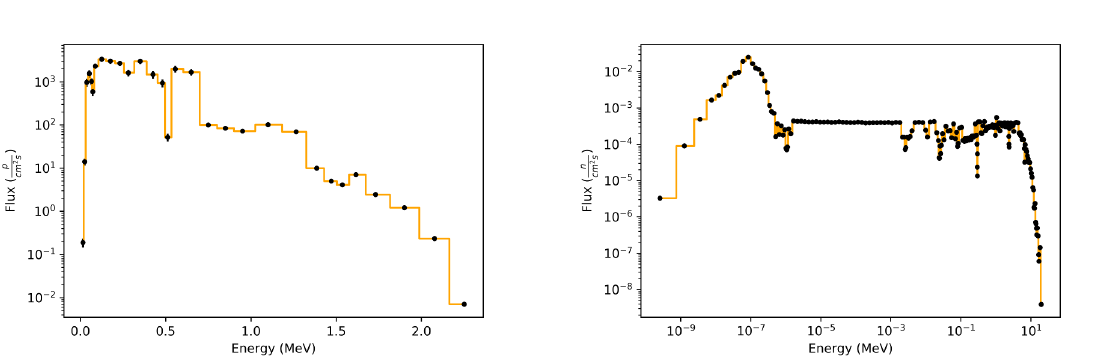
Figure 5: Left: gamma flux in the water volume above the lid. Right: neutron flux in the water volume above the